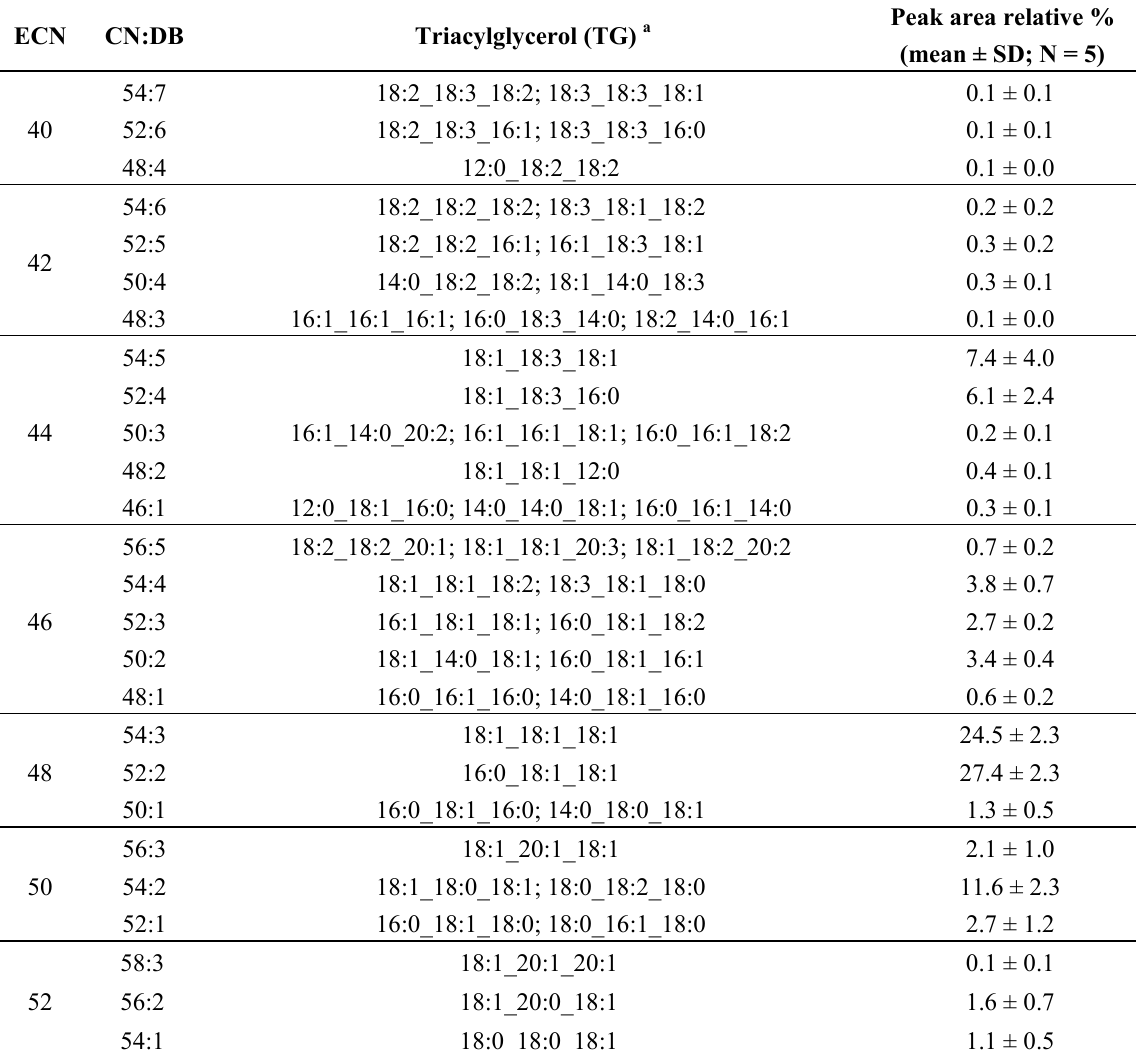
TGs (Table 3 and Table 5) in various quantities. Palmitvaccenic (11-16:1) and cis -vaccenic (11-18:1) acids together formed 4% of the FA mixture. Almost 23% of TGs bore 20:1 and/or 20:2 FAs (Table 5). Table 4. Composition of triacylglycerols in the fat body of B. campestris